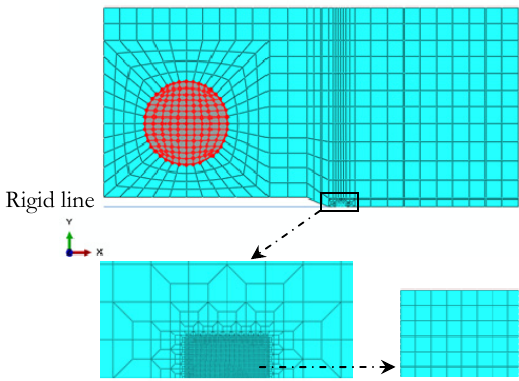
Figure 3: The FE mesh for the half-model of a CT-specimen, where a finer mesh (  ≈ 1.8 µm) was used in the crack tip region.